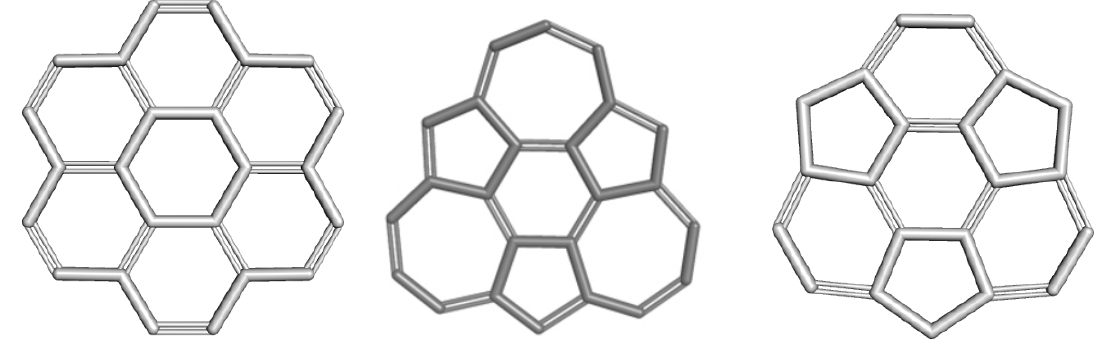
Figure 2. Circulenes: coronene [6:6